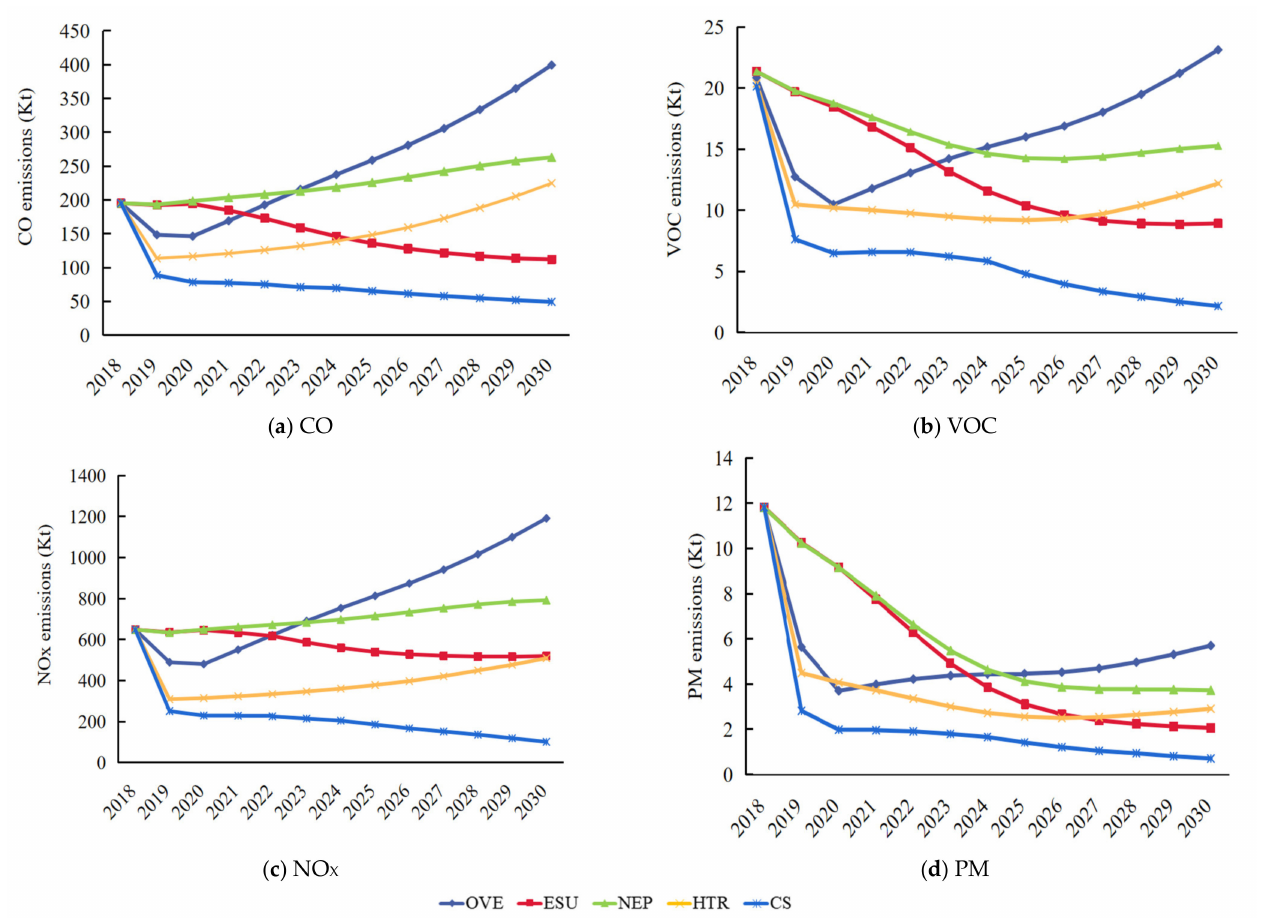
Figure 3. Prediction of pollutant emissions from diesel vehicles under different policy scenarios in the BTH